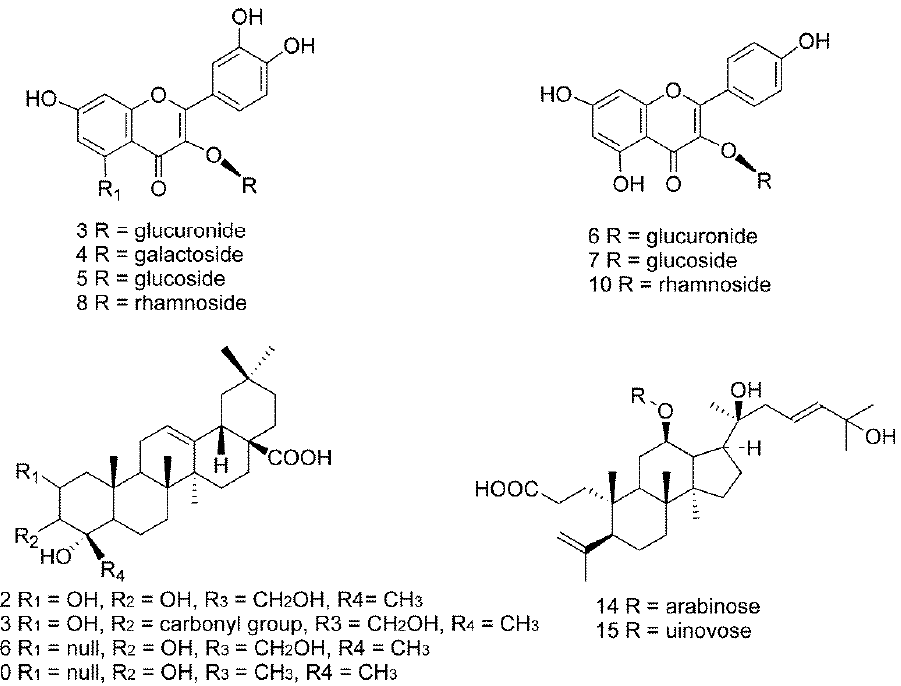
Figure 2. Chemical structures of the 16 quantitative compounds in leaves of C. paliurus: ( 1 ) 3- O -caffeoylquinic acid; ( 2 ) 4- O -caffeoylquinic acid; ( 3 ) quercetin-3- O -glucuronide; ( 4 ) quercetin-3- O -galactoside; ( 5 ) isoquercitrin; ( 6 ) kaempferol-3- O -glucuronide; ( 7 ) kaempferol 3- O -glucoside; ( 8 ) quercetin-3- O -rhamnoside; ( 9 ) 4,5-di- O -caffeoylquinic acid; ( 10 ) kaempferol-3- O -rhamnoside; ( 12 ) arjunolic acid; ( 13 ) cyclocaric acid B; ( 14 ) pterocaryoside B; ( 15 ) pterocaryoside A; ( 16 ) hederagenin; ( 20 ) oleanolic acid. Table 2. Identification of 21 compounds from leaves of C. paliurus by developed HPLC–Q–TOF–MS. Peak No.